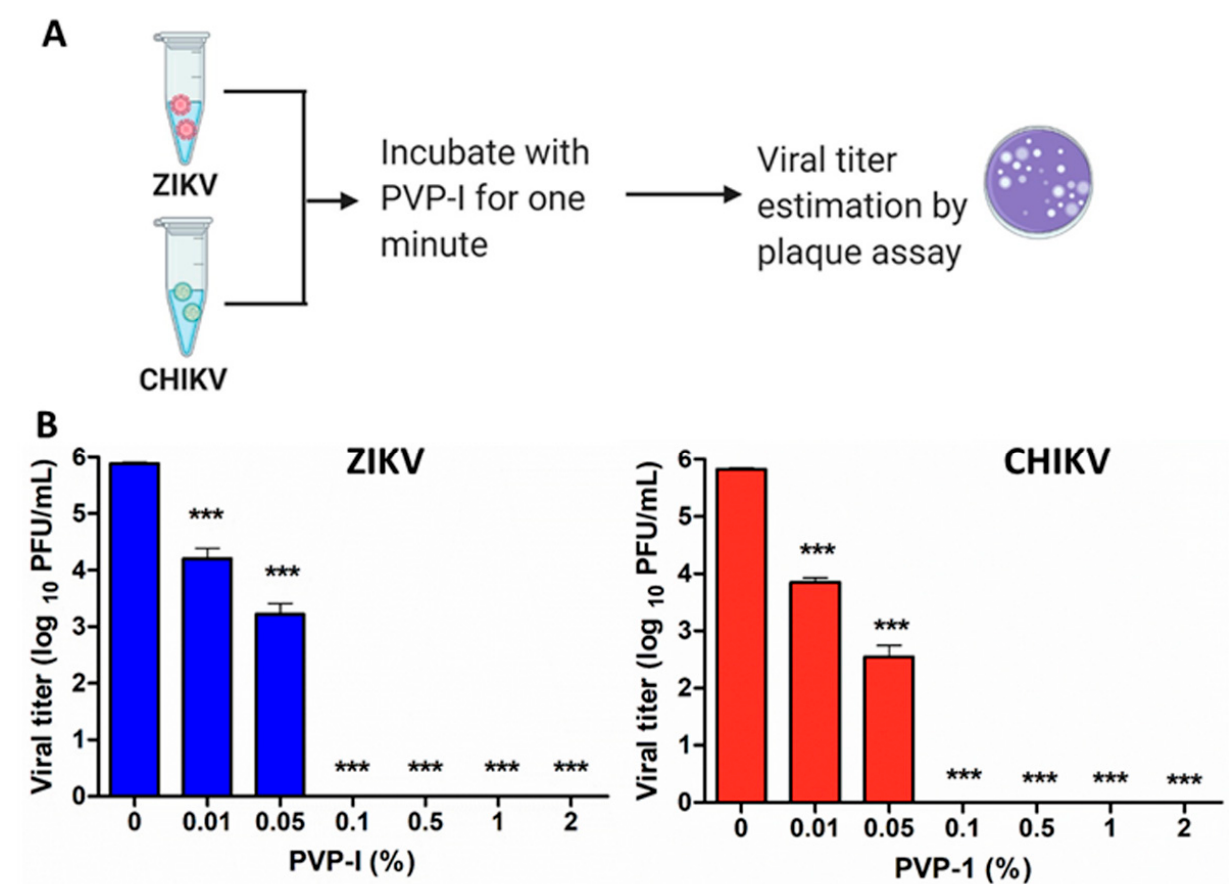
Figure 1. Direct inactivation of enveloped RNA viruses by PVP-I. ( A ) Schematic representation of the method used to assess the virucidal activity of PVP-I. ( B ) Zika virus (ZIKV) and Chikungunya virus (CHIKV) were incubated with indicated concentrations of PVP-I for one minute followed by plaque assay on Vero cells. The viral titer was expressed as log 10 PFU/mL. One-way ANOVA with Dunnett’s test was used for statistical analysis wherein, *** p < 0.001.